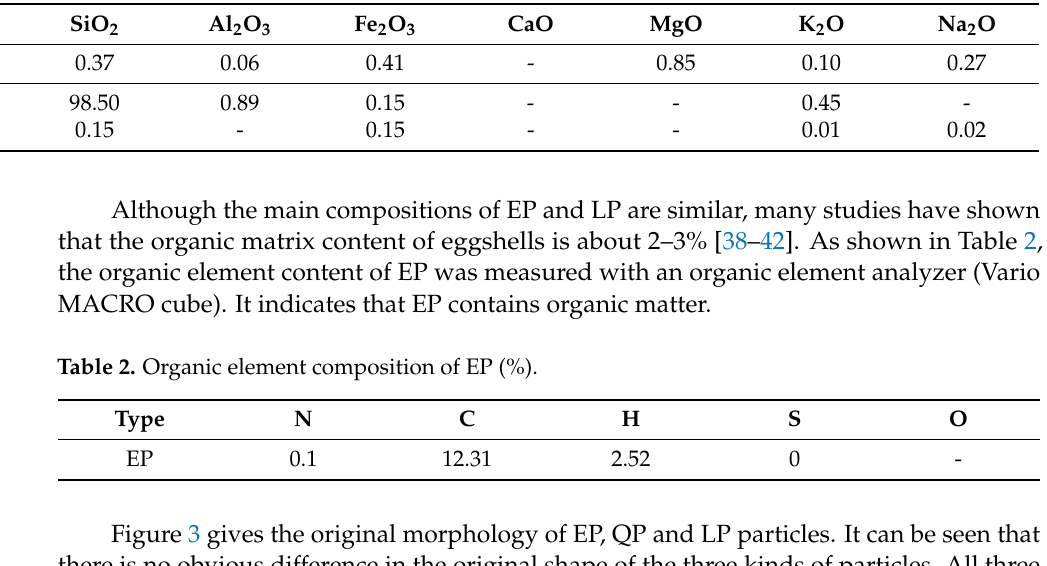
Table 1. Chemical composition of EP, QP and LP (% by mass).